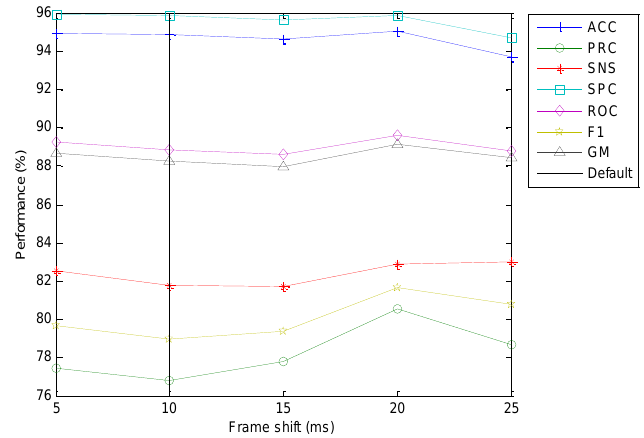
Figure 23. Classification performance metrics of the best classifier vs. the frame shift.